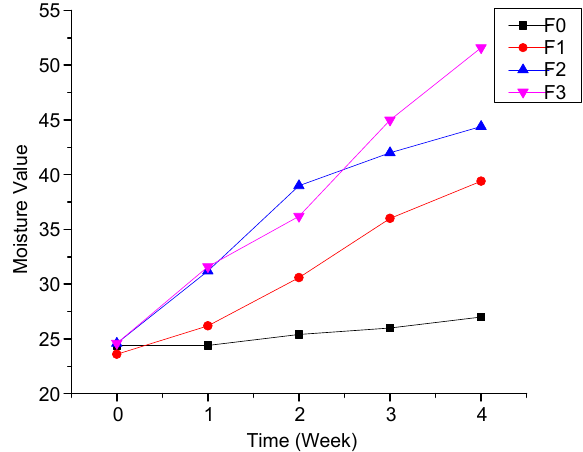
Fig. 2. Graph of the effect of hydrogel preparations for eye mask water extract of yellow potato tubers on skin pore values